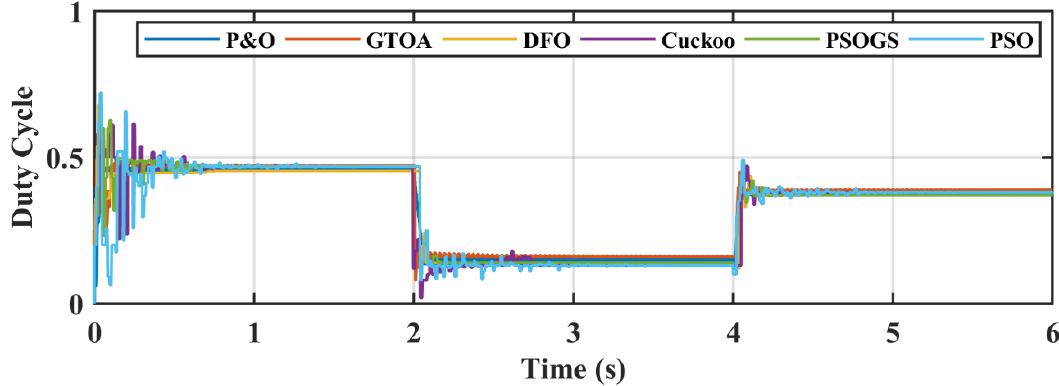
Figure 11. Comparison of duty cycle of GTOA.